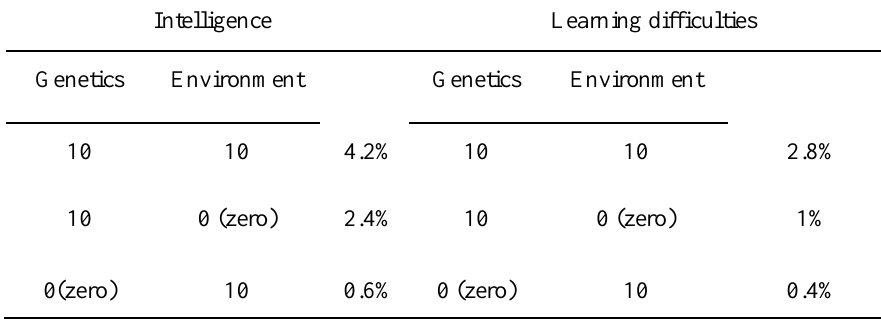
Percentages of simultaneous responses to extreme values on numerical scales from 0 to 10 on the influence of genetic and environmental influence on intelligence and learning